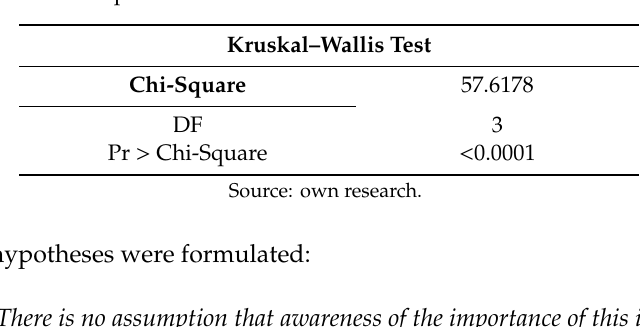
Table 8. Kruskal–Wallis Test: The relationship between the perception of the importance of principles and their implementation in